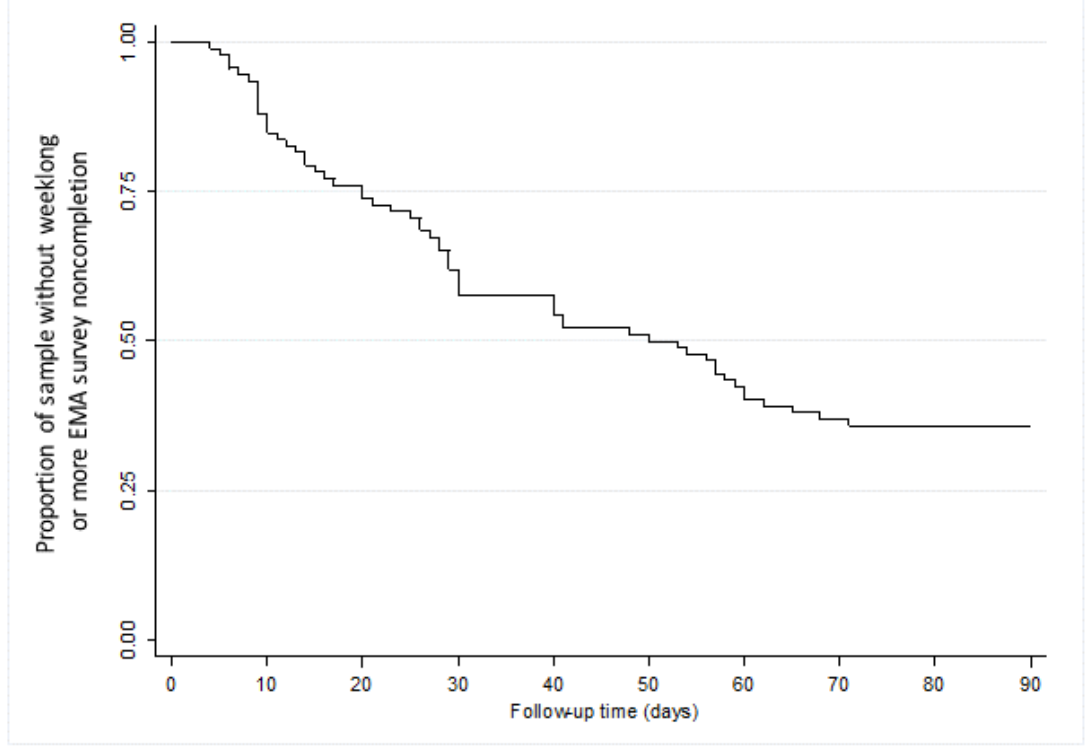
Figure 2. Kaplan-Meier survival curve visualizing the proportion of sample (excluding nonstarters, n=28) without a weeklong or more EMA survey noncompletion over the 90-day follow-up period from the 2017-2018 Health eNav study